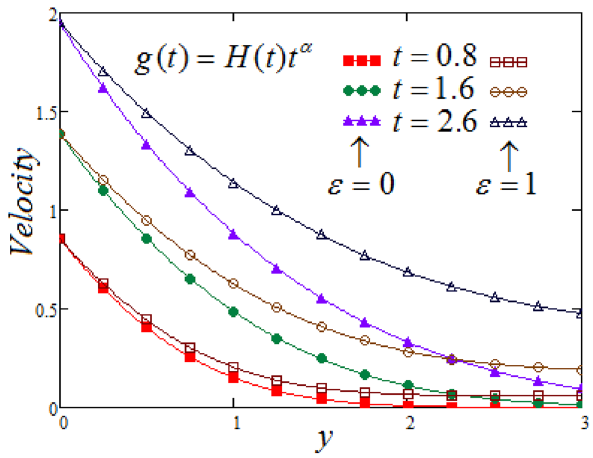
Figure 2. Representation of fluid velocity v ( y , t ) against y for distinct values of t with Pr eff = 4.5, Sc = 0.8, (cid:31)